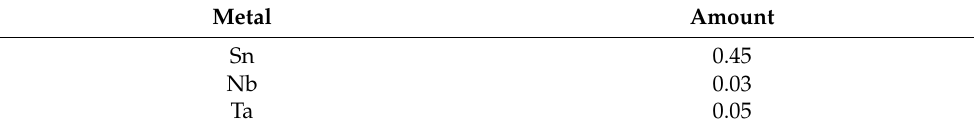
Table 2. Metal output (in t/h).